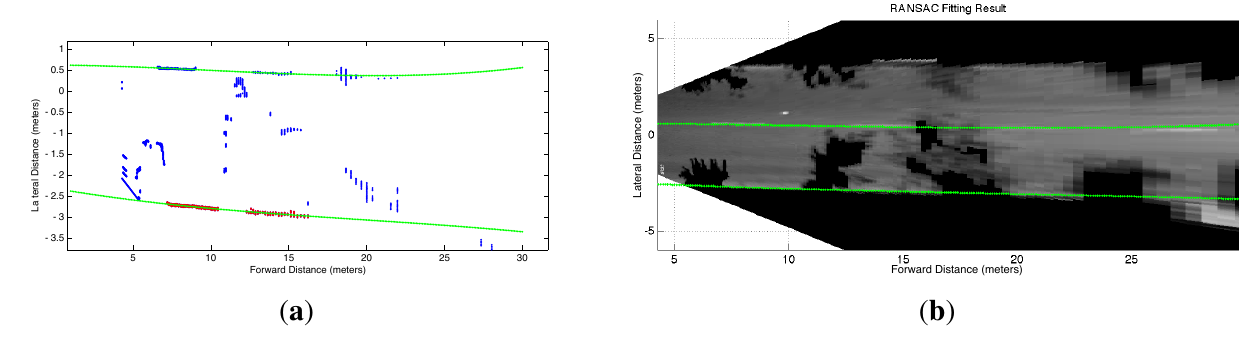
Figure 6. MSAC cubic polynomial fitting (green) in a street with many tree shadows. ( a ) Curves fitted to the extracted lane boundaries segments (top-view); ( b ) Lane boundaries superimposed on the segmented street pavement